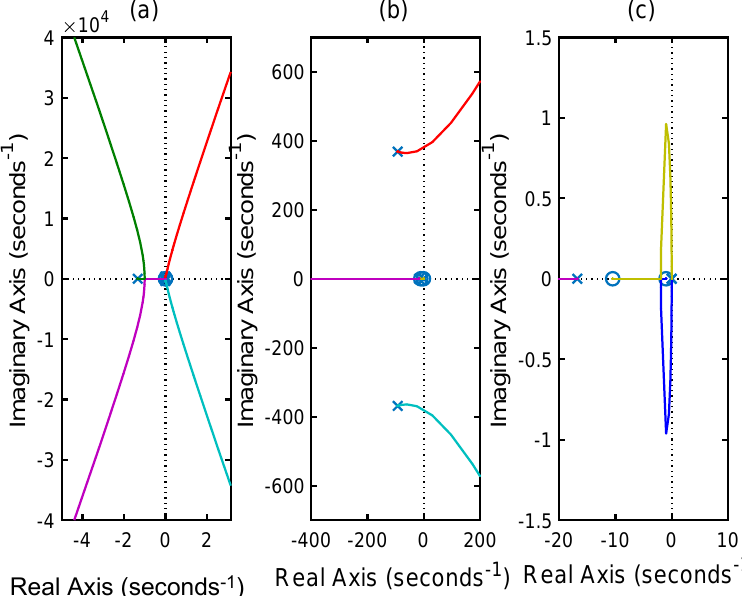
Figure 8. ( a ) The overall trend of the root locus. ( b , c ) show enlarged images of different proportions Figure 8. The root locus of the sensorless system. of poles, respectivelyof the sensorless system. It is well known that to ensure the stability of the system, all root trajectories should